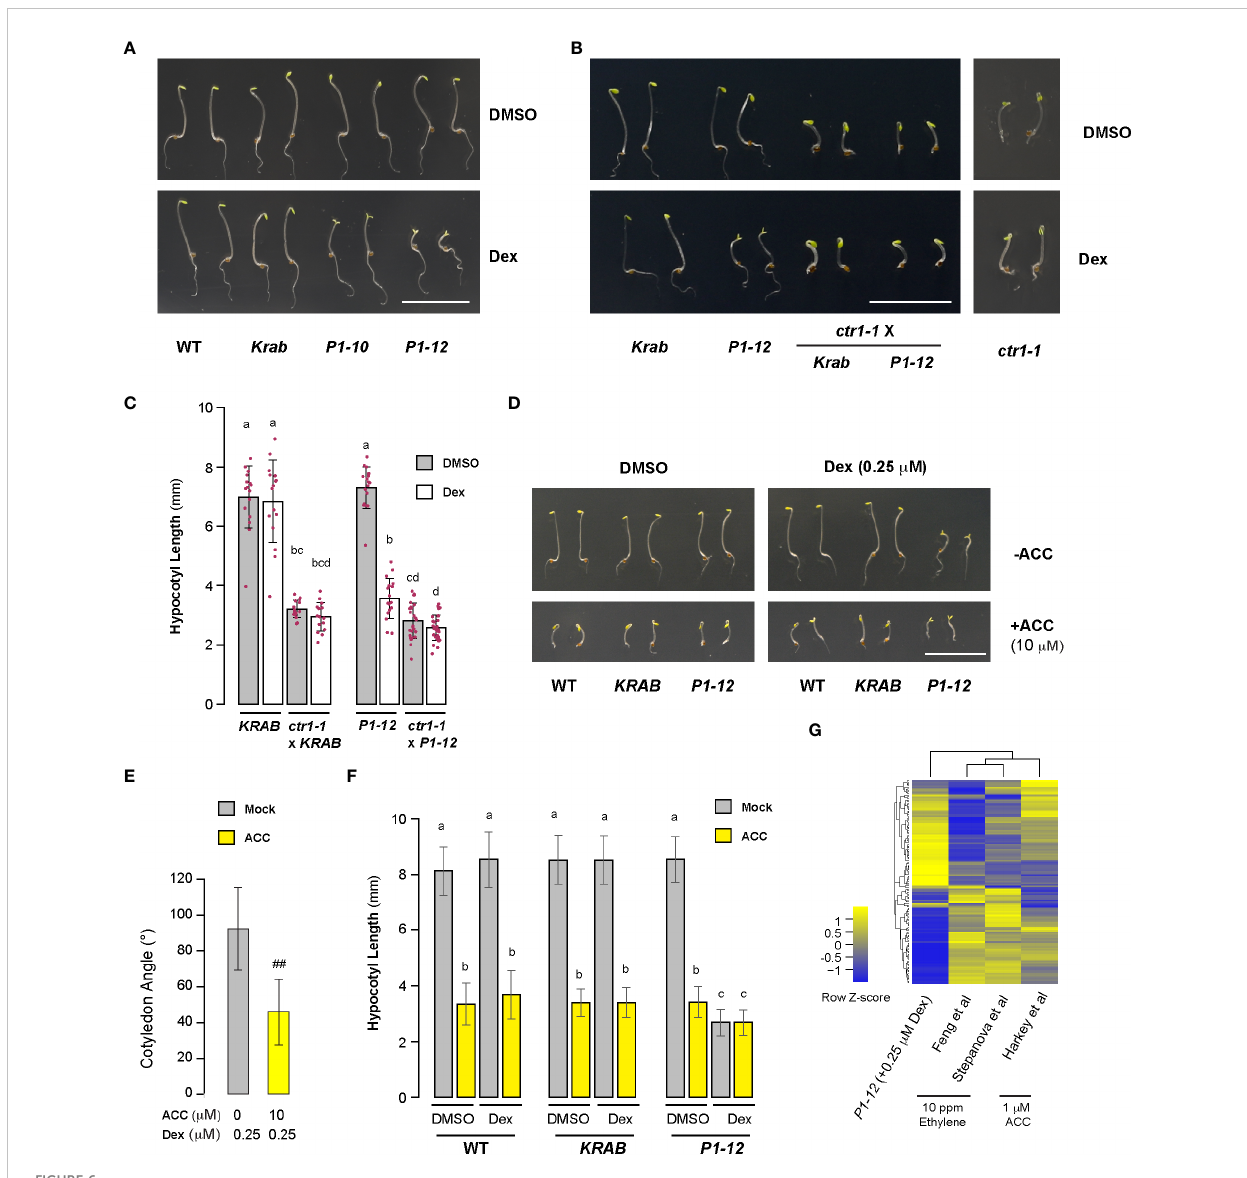
FIGURE 6 Skotomorphogenesis is partially suppressed by compromised ethylene signaling in P1 seedlings upon Dex treatment. (A, B) Representative images of seedlings from indicated genotypes grown for 3 d in dark on media containing DMSO or 0.25 m M Dex. Bar = 1 cm. Growth images of ctr1-1 were included to show its insensitivity to Dex treatment. (C) Quantitative analysis of hypocotyl length of seedlings as shown in (B) suggests that MORF2 impacts ethylene signaling upstream of CTR1. Each bar herein as well as in (E) and (F) represents mean ± SD. The data points of replicates are indicated with maroon dots (n=16 except for ctr1-1 x P1-12 , which has 28 replicates). Different letters on the top of each bar indicate signi fi cant differences (Kruskal-Wallis test followed by Dunn ’ s test with Benjamini-Hochberg multiple testing correction, P < 0.05). (D) Images of representative seedlings grown for 3 d in dark on media supplemented with indicated combinations of DMSO, 0.25 m M Dex, and 10 m M ACC. (E) ACC treatment partially suppressed cotyledon opening of P1-12 (+0.25 m M Dex) (##: Student ’ s t -test, P < 0.01; n=71 and 64 for mock and ACC